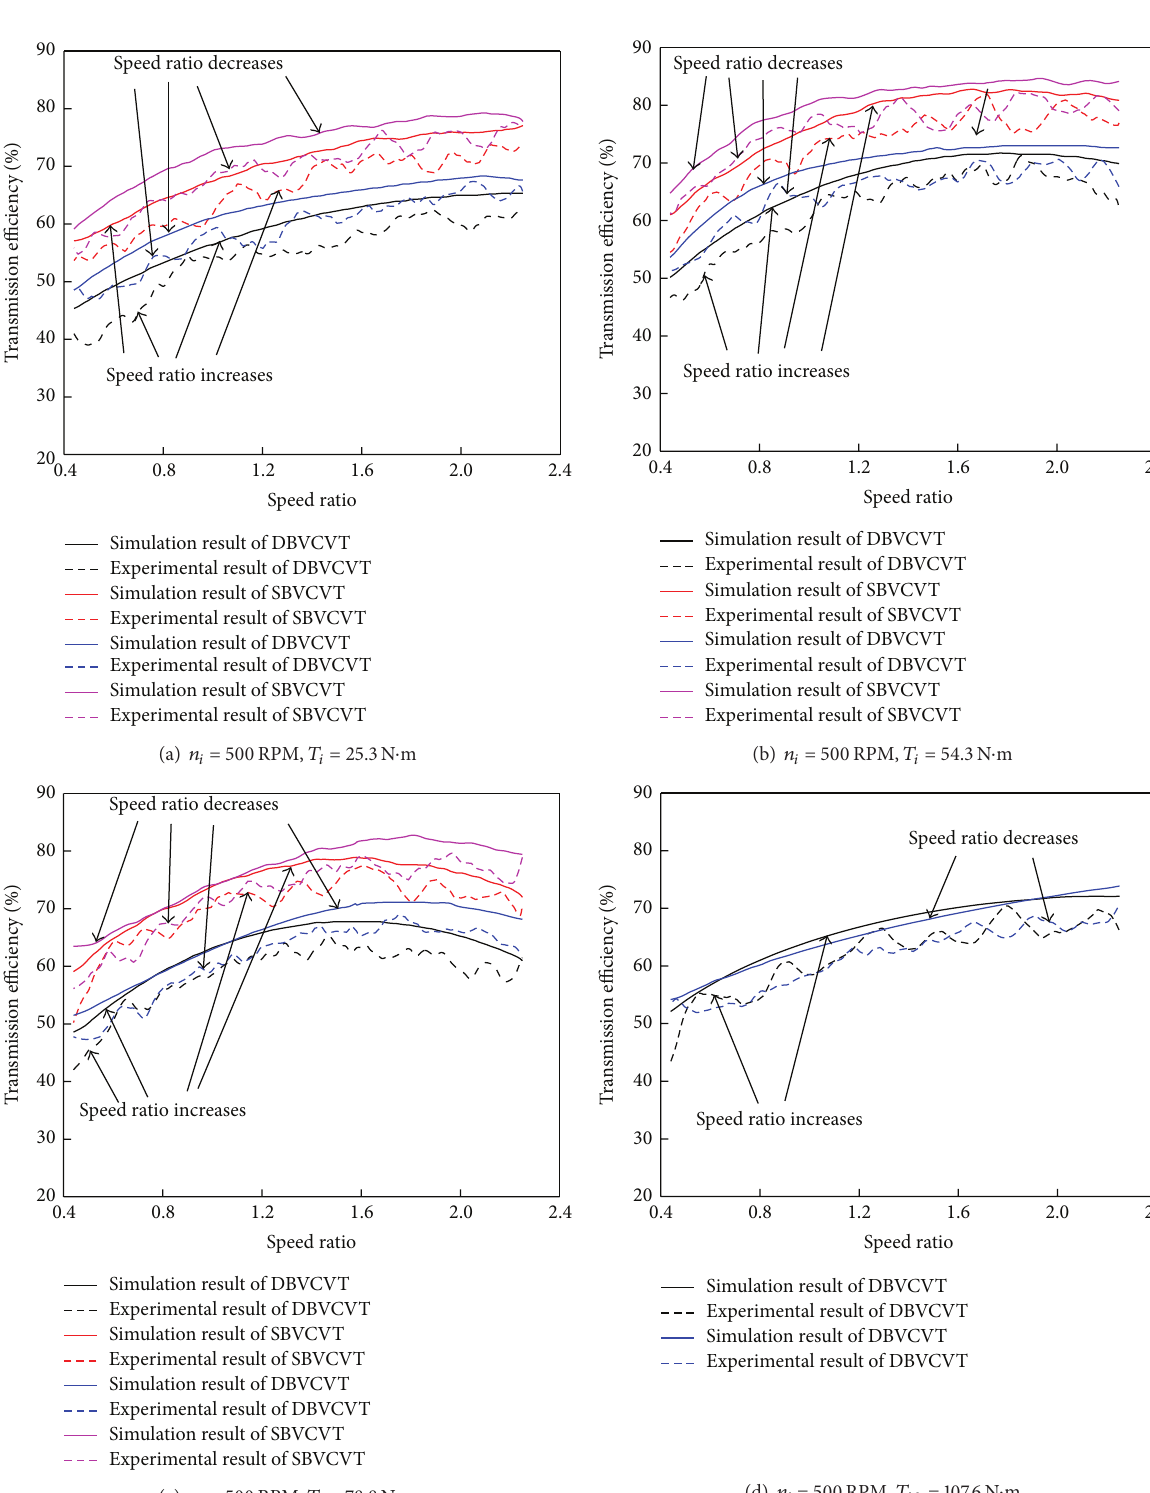
Figure 12: Comparison of simulation and experimental results of transmission efficiencies under 𝑛 𝑖 = 500